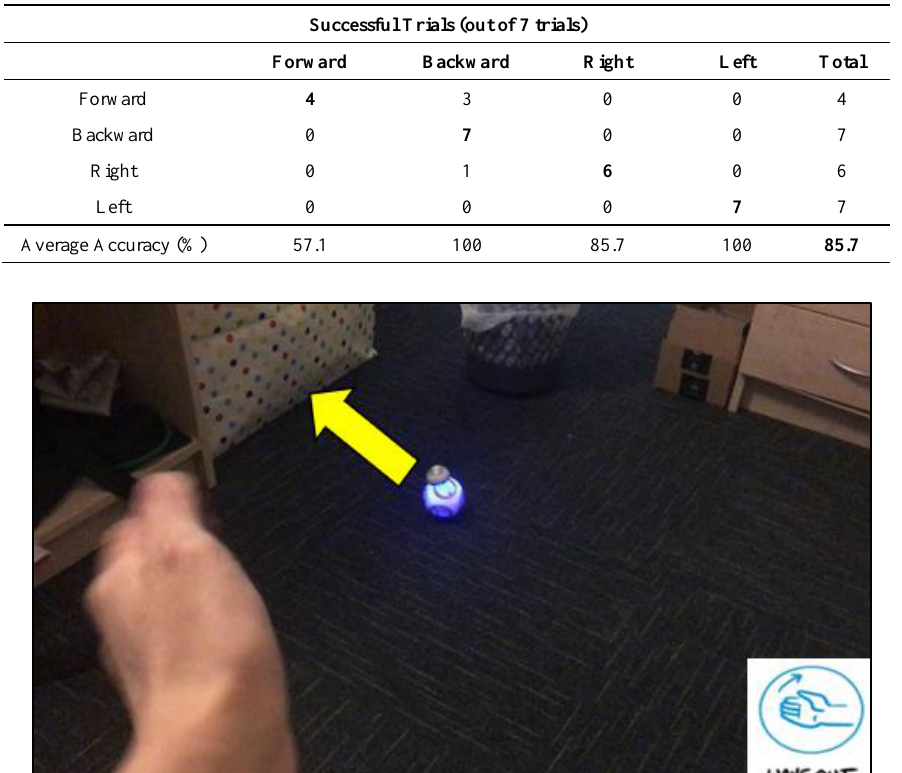
Table 2. Confusion Matrix, First Test, Inexperienced User